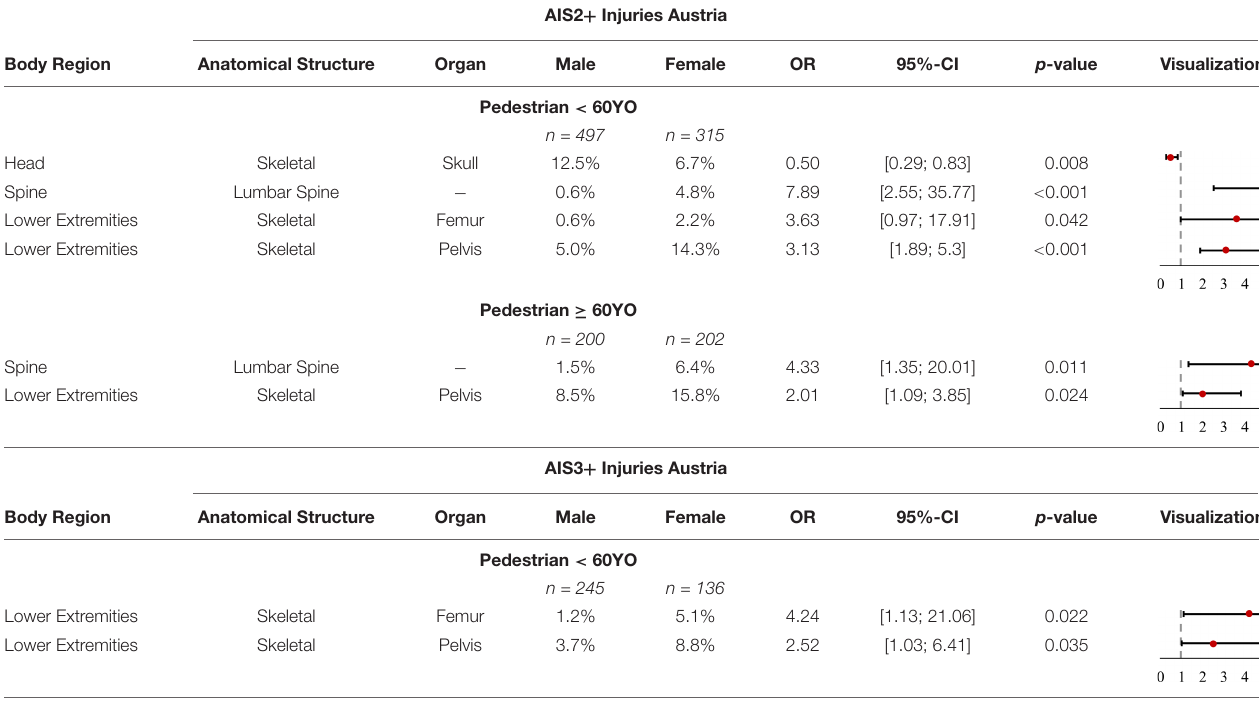
TABLE 7 | Share of AIS2 + and AIS3 + injuries with significant differences, OR and p -value in Austria for pedestrians and cyclists < 60YO and ≥